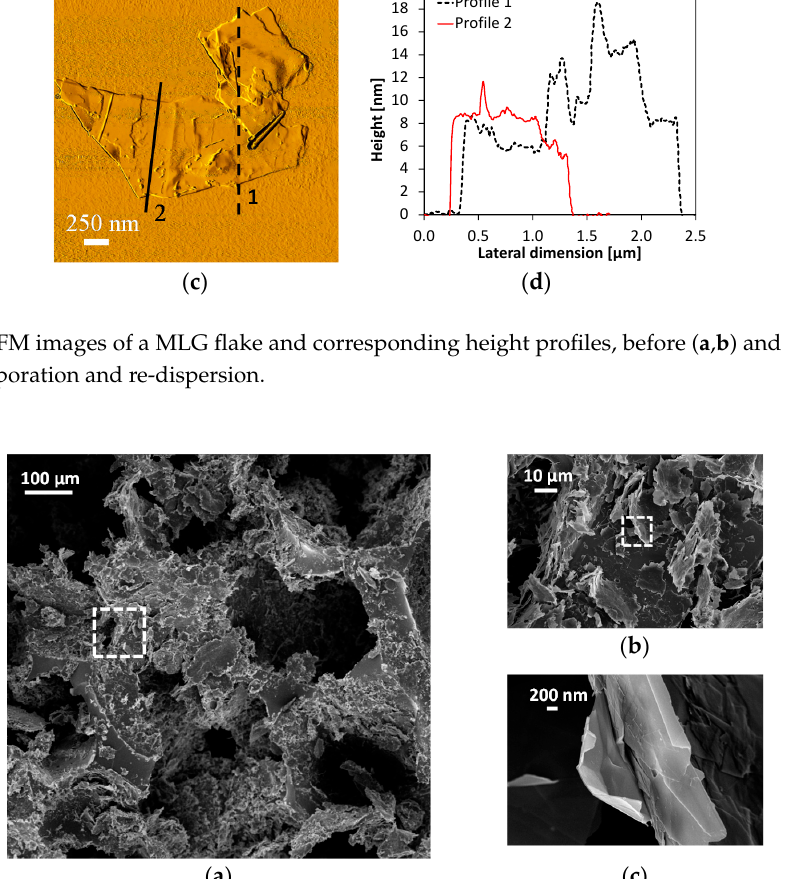
Figure 7. ( a ) SEM image of a MLGs coated PDMS foam; ( b ) Higher magnification view of the area marked in ( a ); ( c ) Higher magnification of flakes marked in ( b ).